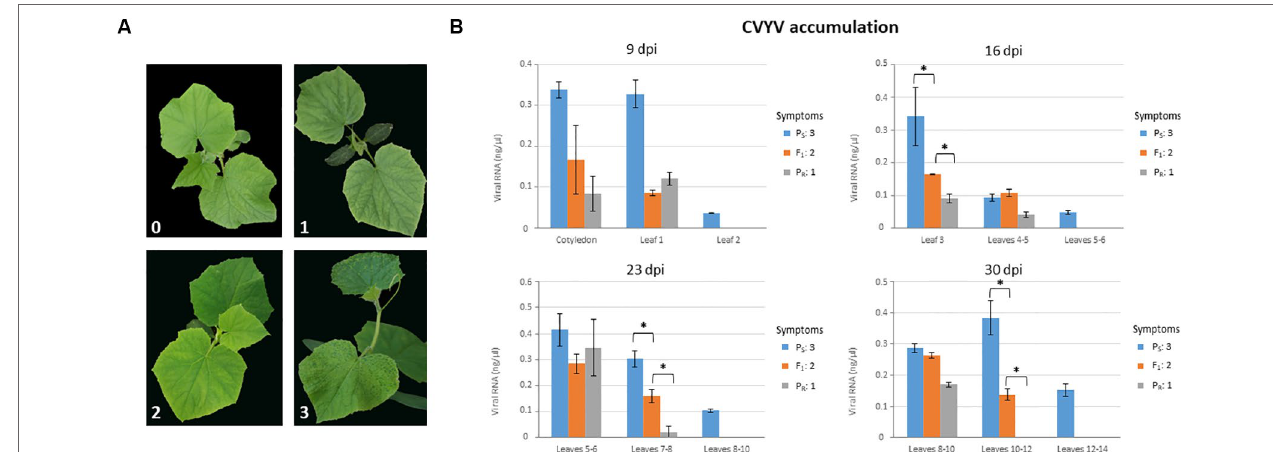
FIgURe 1 | Phenotyping plants of the susceptible (P S ) and resistant (P R ) parental lines, and their F 1 , for CVYV susceptibility. Symptoms were scored and virus accumulation was measured at 9, 16, 23 and 30 days post-inoculation (dpi) (A) Symptoms in plants at 9 dpi. Symptoms could be assigned unequivocally to one of the following categories: (0) No symptoms; (1) mild chlorotic mottling in young but fully expanded leaves in interveinal petiole-proximal leaf areas; (2) similar to (1) plus vein yellowing evident in fully expanded leaves and incipient in young developing leaves; (3) obvious vein yellowing in all leaves, including young developing leaves, chlorotic mosaics in fully expanded leaves and overall plant growth reduction. (B) Virus accumulation was measured by quantitative dot-blot hybridization on total plant RNA extracts from basal, intermediate and apical leaves, as indicated for each graph. Three leaf discs (8 mm) were taken per leaf sampled. Virus accumulation in F 1 plants was intermediate between the susceptible and resistant parental lines in basal and intermediate leaves at 16, 23 and 30 dpi, respectively; an asterisk marks statistically significant differences in Kruskal-Wallis tests ( P < 0.027). A minimum of 9 plants were used per treatment. Symptom category (as in (A)) is indicated for each line on the right side of each graph for each time period after inoculation.